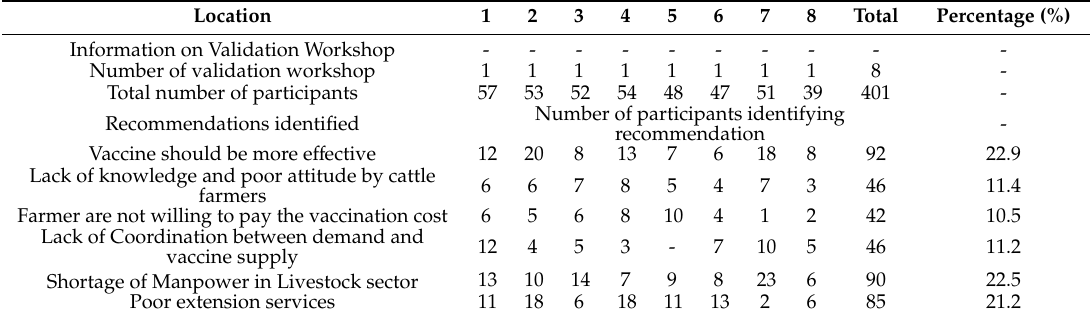
Table 3. Additional recommendation for maximizing vaccine uptake form Validation